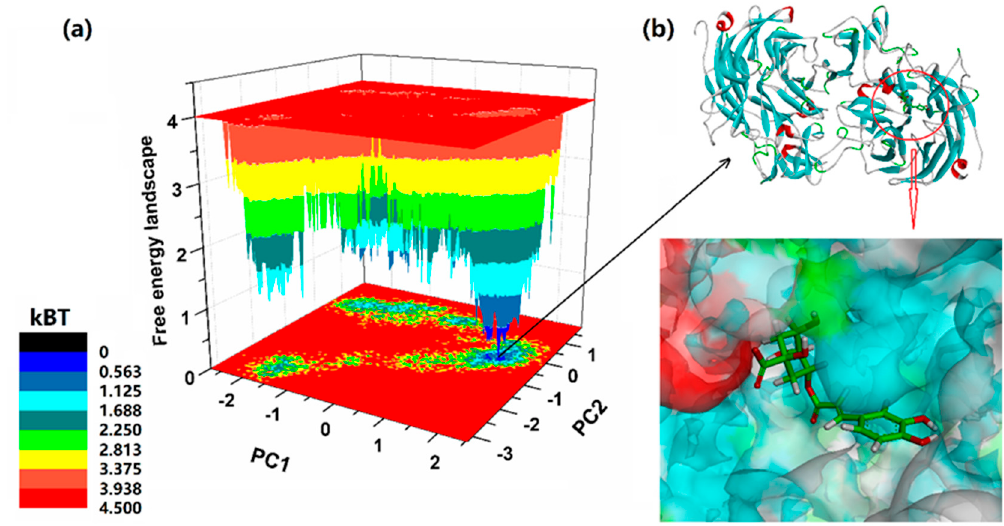
Figure 3. ( a ) Relative free energy surfaces along the first two principle components (PC1, PC2) of the NanA–chlorogenic acid complex. ( b ) Predicted integral binding poses of NanA–chlorogenic acid.